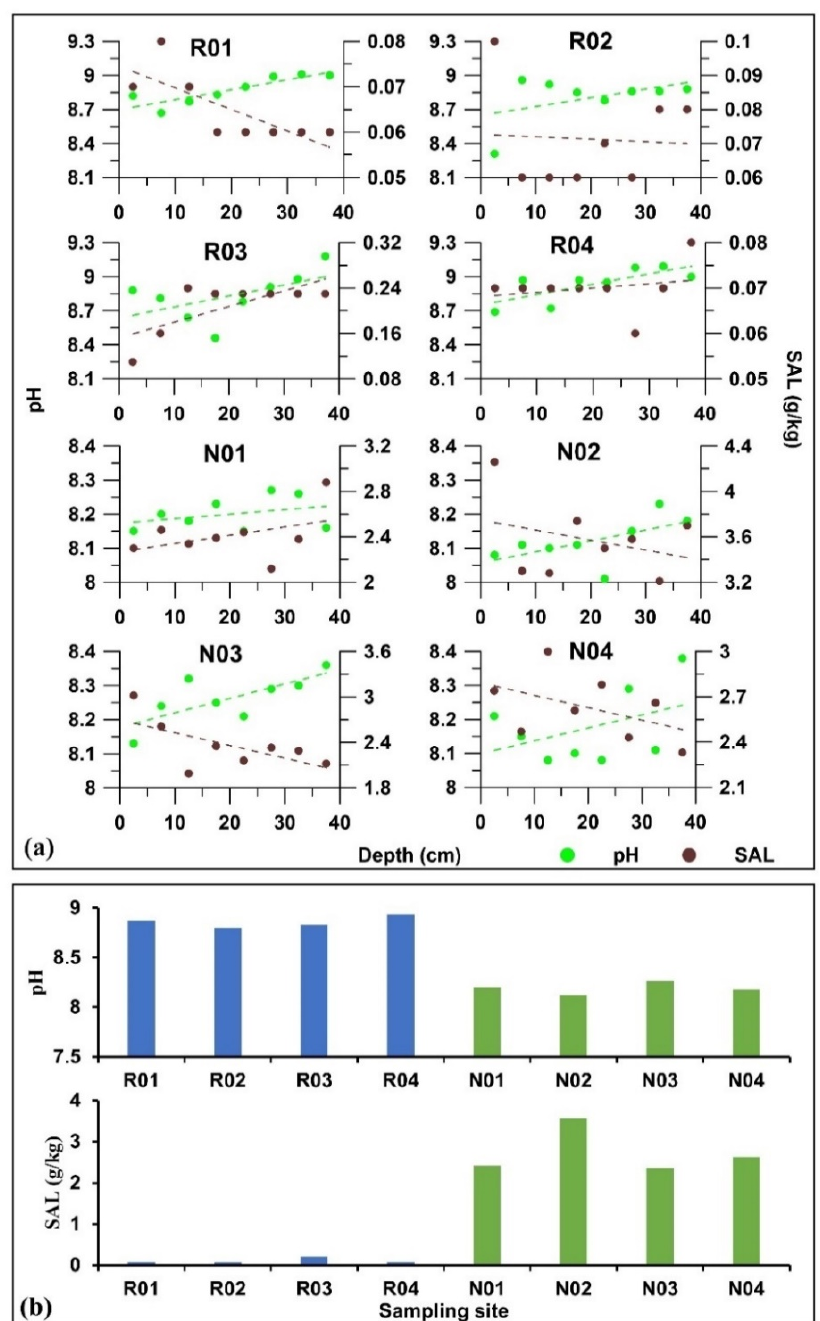
Figure 3. Comparison of changes in pH and salinity with depth at each sampling site. ( a ) The change in pH and salinity with depth; ( b ) the mean pH and salinity at each sampling site.